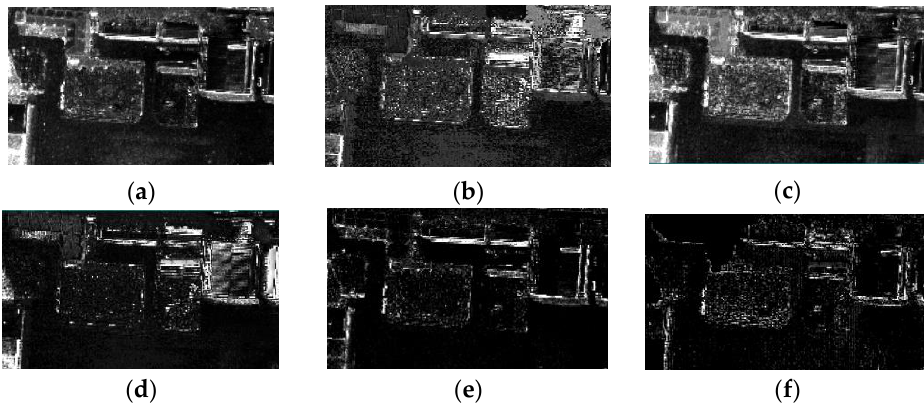
Figure 14. The target detection results of the different methods on the car data set. ( a ) RXD; ( b ) SegRX; ( c ) LRASR; ( d ) LSMAD; ( e ) LELRP-AD; and ( f ) EaSLRP.